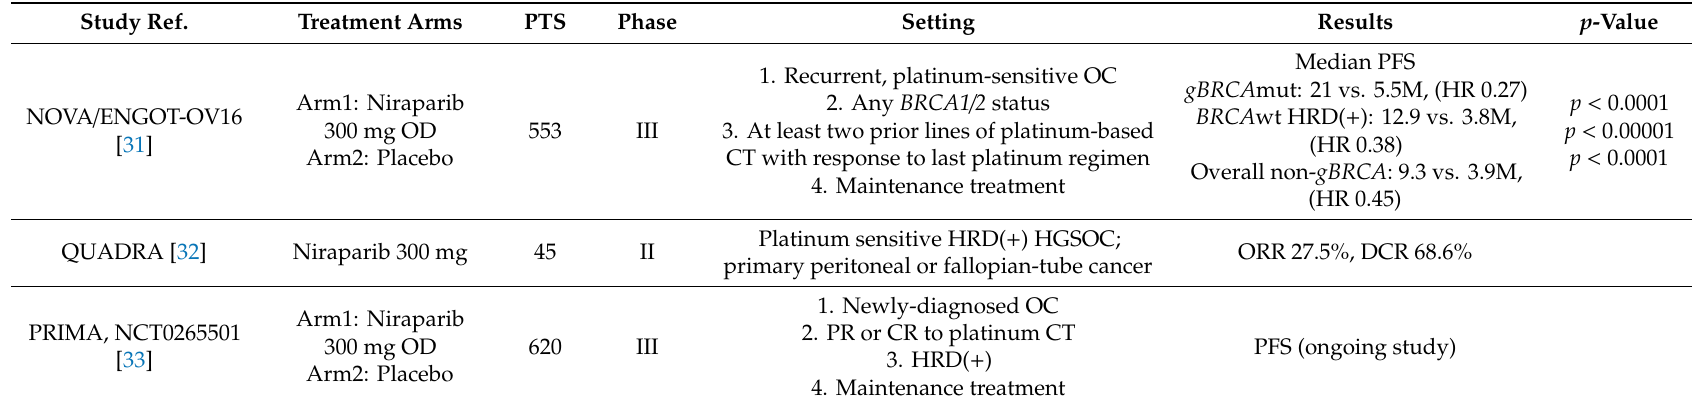
Table 2. Clinical trials results for Niraparib in